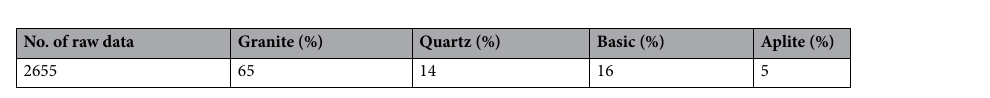
Table 1. Descriptive statistics of lithological raw